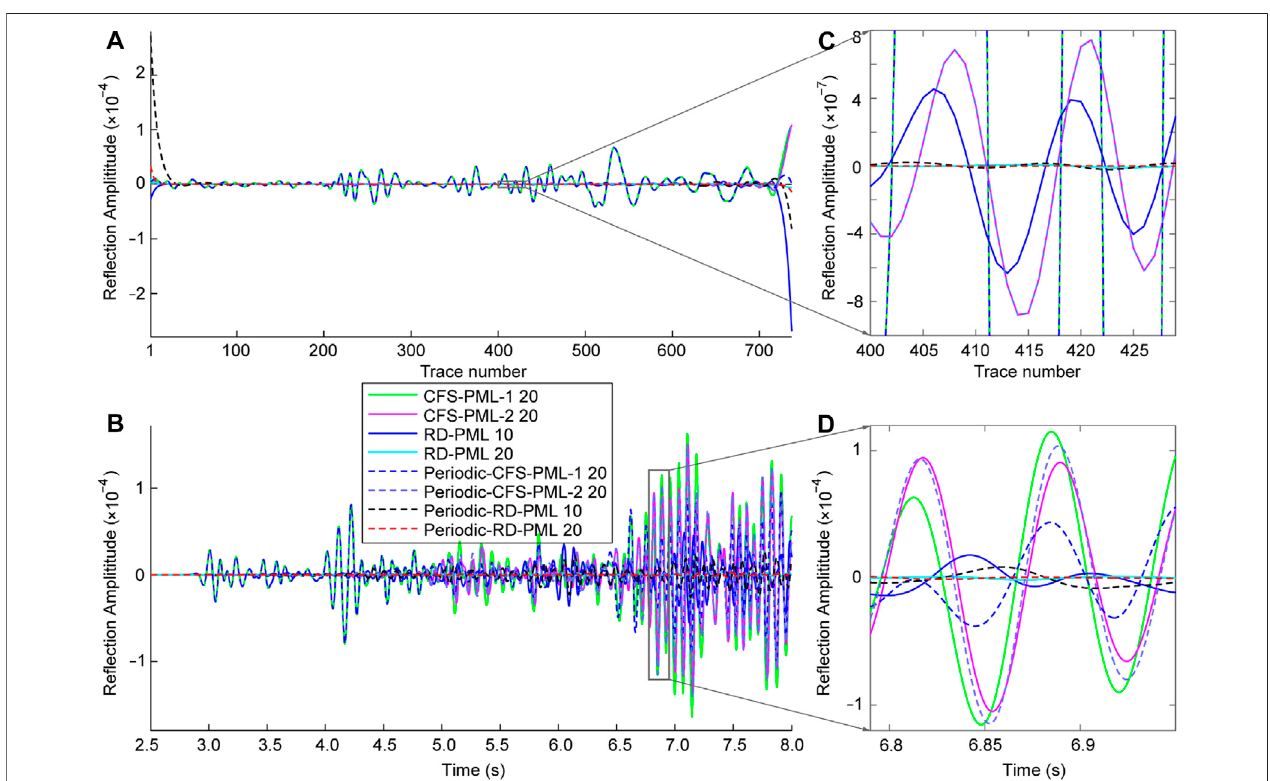
FIGURE 12 | Arti fi cial re fl ections obtained by the wave fi eld difference between the shot records and the reference shot records. (A) and (B) are the waveforms along the horizontal dashed line and the vertical dashed line in Figure 11 , respectively. (C) and (D) are the enlarged portions of the frame in (A) and (B) , respectively.